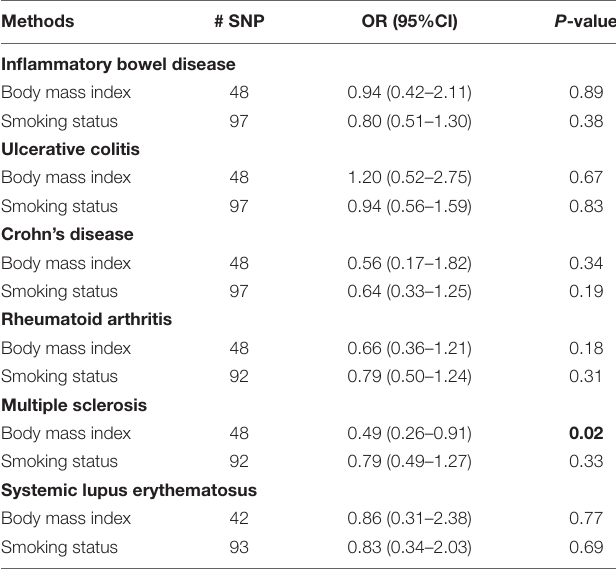
TABLE 3 | Genetically predicted levels of alcohol consumption and risk of common autoimmune